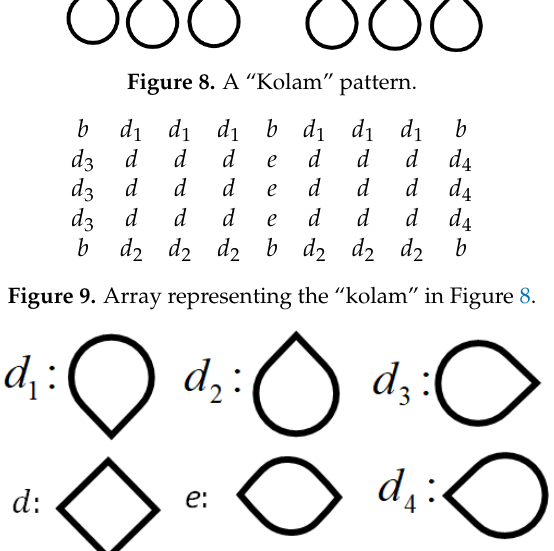
Figure 8. A “Kolam” pattern.